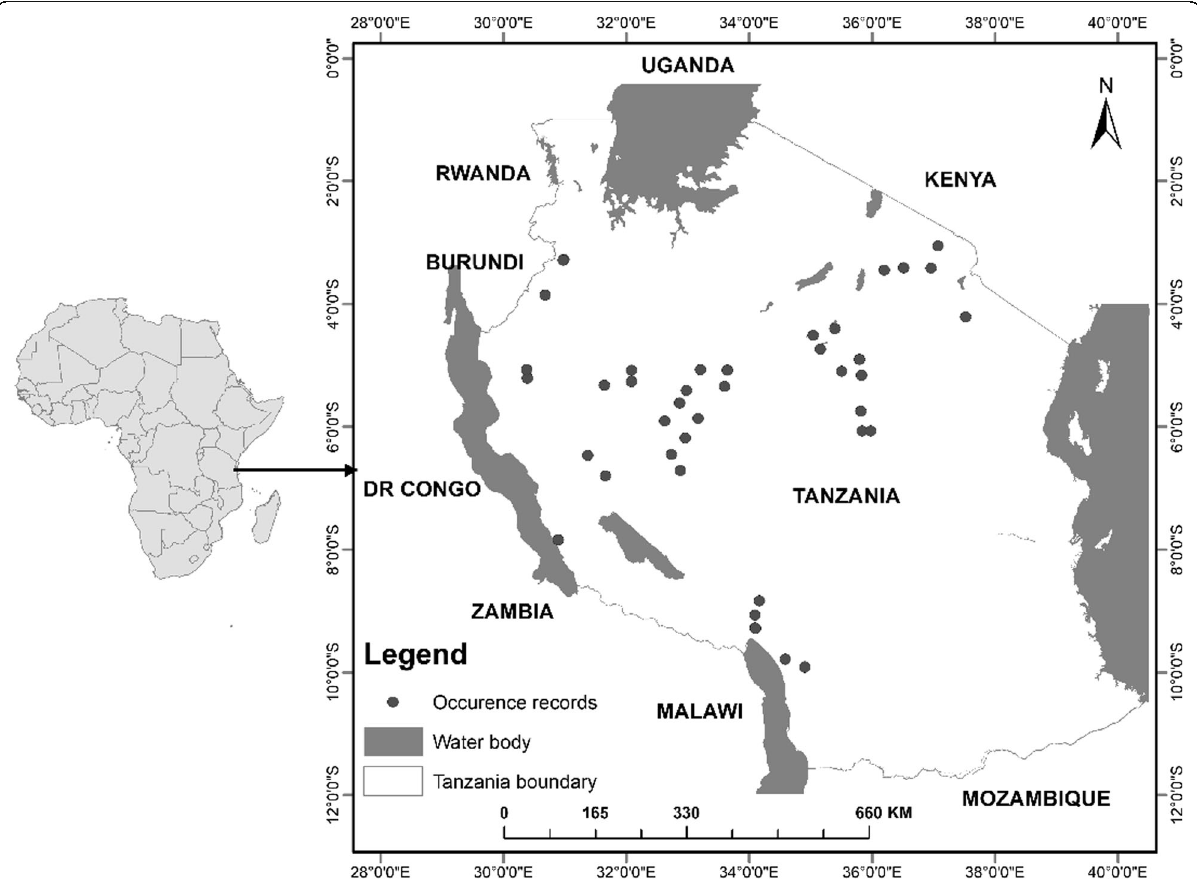
Fig. 1 Occurrence and distribution of V. destructor in the study